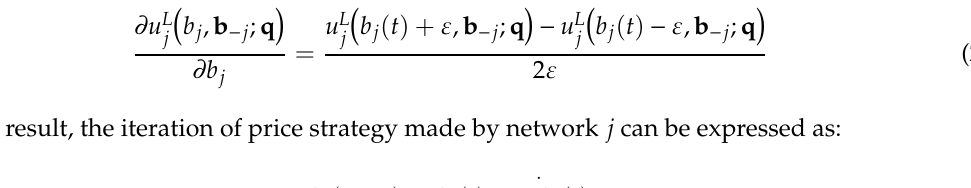
Algorithm 1 details the proposed two-tier game-based distributed resource allocation algorithm.